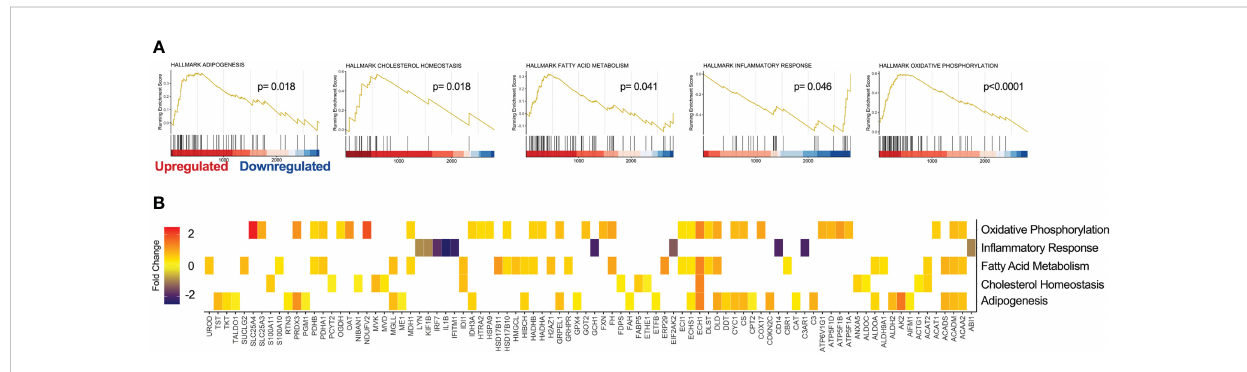
FIGURE 6 Gene Set Enrichment Analysis (GSEA) reveals cellular pathways modi fi ed by PHX on M1 macrophages. GSEA of 2999 proteins derived from vehicle or 5 m M treated M1 macrophages using the Molecular Signatures Database (MSigDB) Hallmark data set. (A) Enrichment Score (ES) plots of statistically signi fi cant enriched Hallmark data gene sets. (B) Heatmap identifying protein expression associated with each Hallmark gene